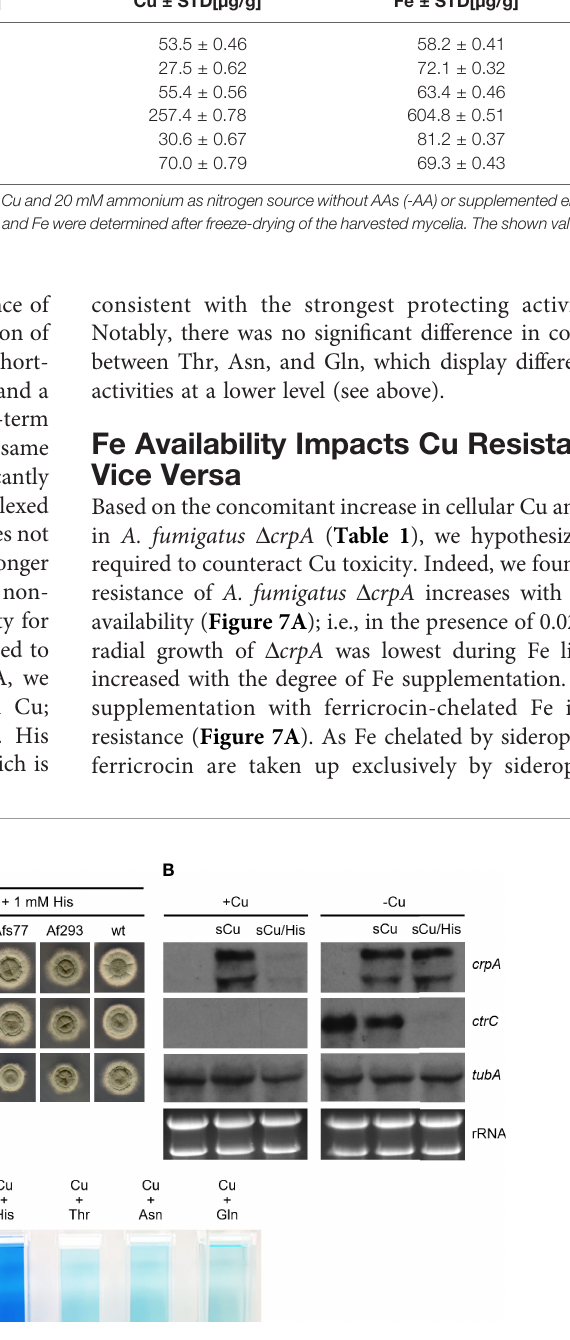
TABLE 1 | AA supplementation impacts biomass production and cellular contents in Cu and Fe of D crpA . Strain Supplement